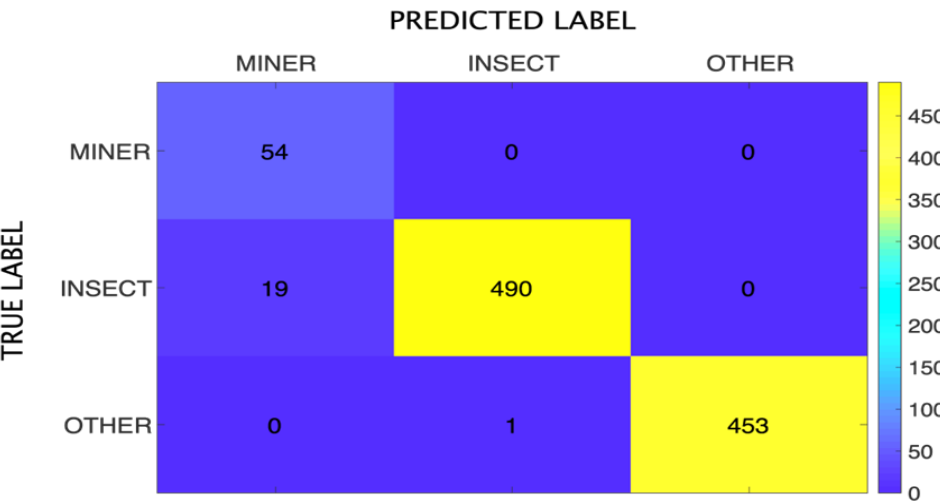
Figure 10. Example of the automatic counts of the model for the Vegetation Monitoring Device (VMD). Green bounding boxes – detected classes (MINES, OTHER).